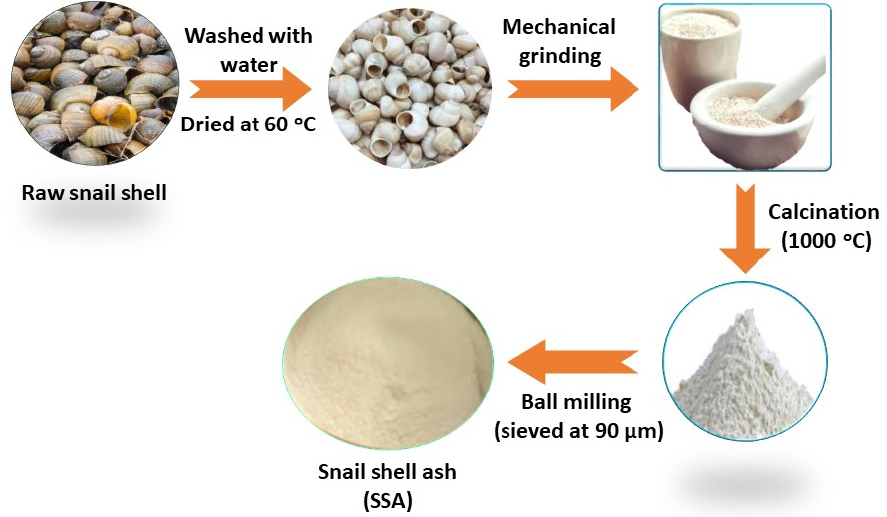
Figure 1. Flow chart for the preparation methodology of snail shell ash (SSA).